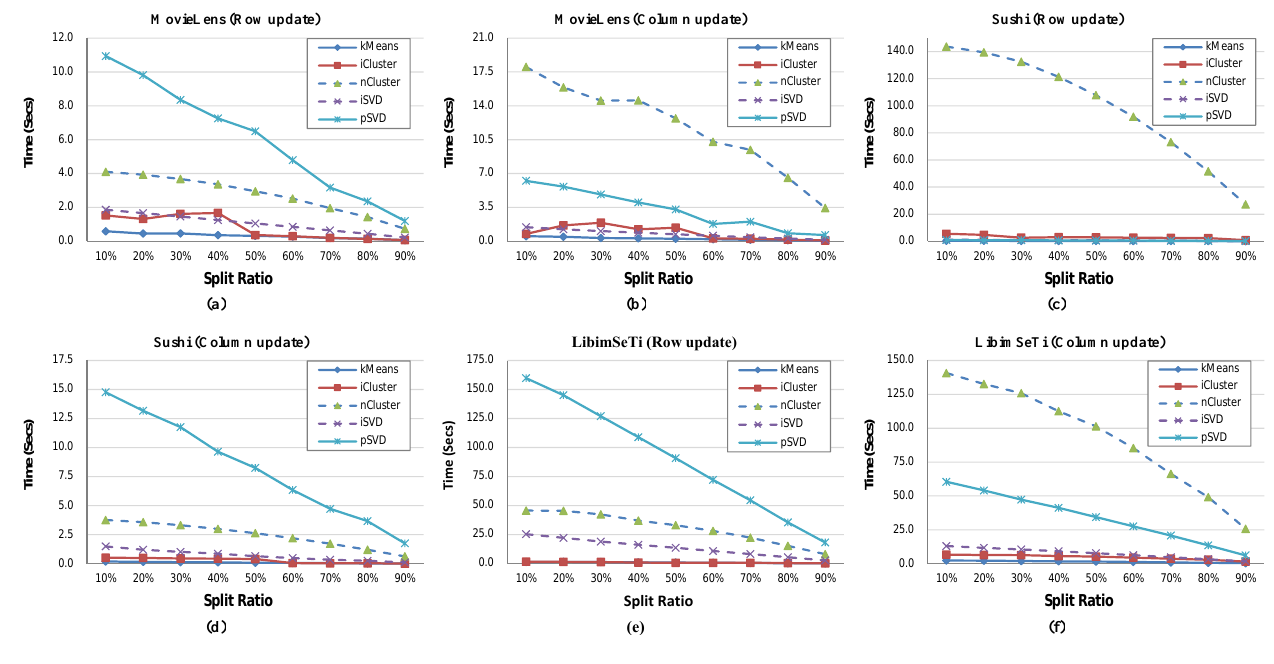
Figure 2. Time cost variation with split ratio Table 4. Optimal number of clusters on the Sushi